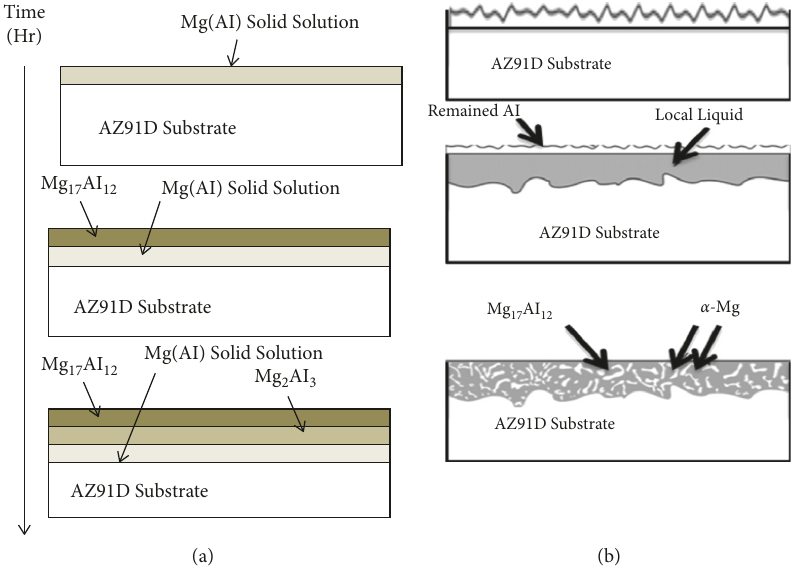
Figure 1: Growth of the surface layers on AZ91D Mg during the coating. (a) Below 437 ° C and (b) above 437 °